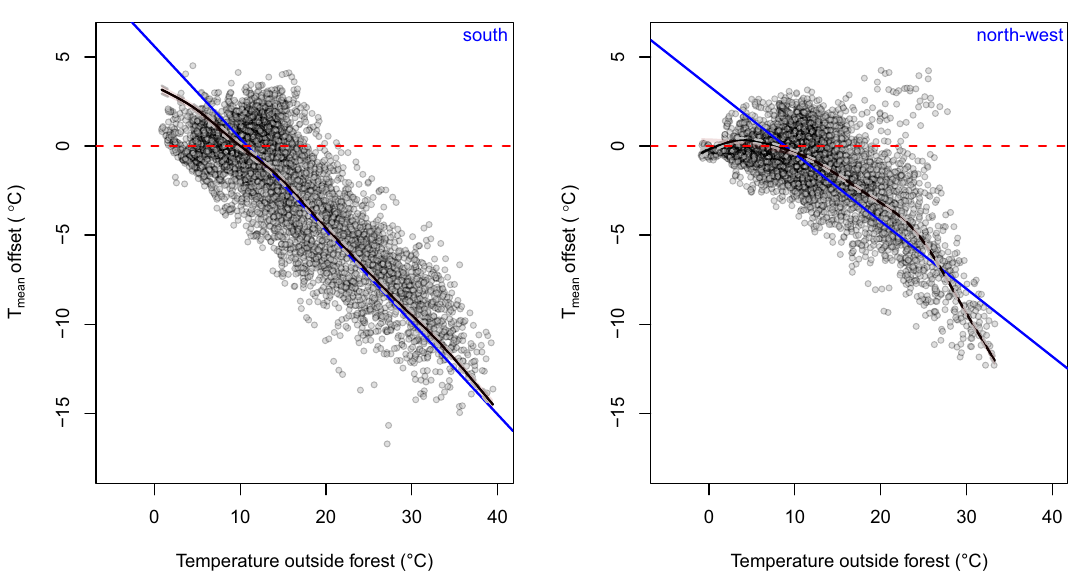
Figure 5. Relationships between the average near-ground temperatures in open-field (set as reference) and below-canopy temperature offset during the growing season (from May to September) using General Additive Mixed Models (GAMMs) for south (left panel) and northwest (right panel) treelines, respectively. Solid black lines show the fitted GAMMs with month, day and hour as nested random-effect terms (dashed gray lines and gray shaded areas between the dashed lines show the standard error around the predicted values); solid blue lines show the fitted linear mixed-effects models (LMMs) with a nested random-effect term for South (intercept = 5.6, slope = -0.51; p < 0.001) and North (intercept = 3.37, slope = -0.37; p < 0.001); red dashed lines show the null line (temperature offset = 0 °C or below-canopy equals open-field temperature). G.S. represents the growing season from May to